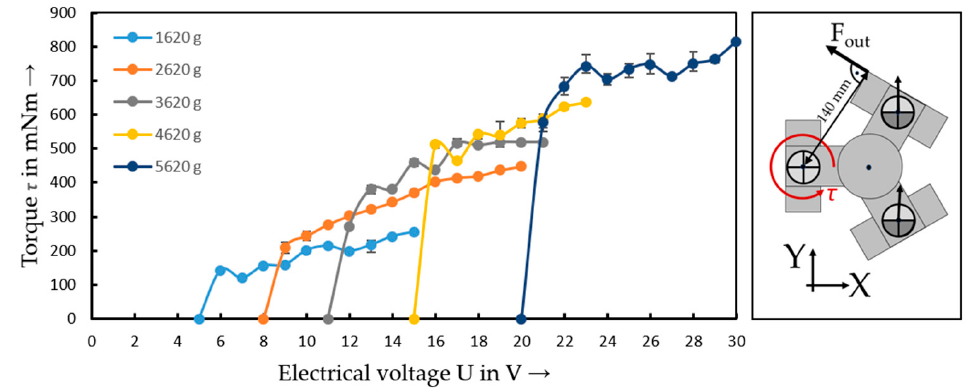
Figure 14. Resulting torque τ from rotation around Piezo 1.